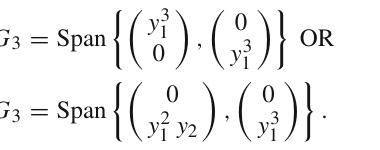
, x ) -plane corresponds 1 2